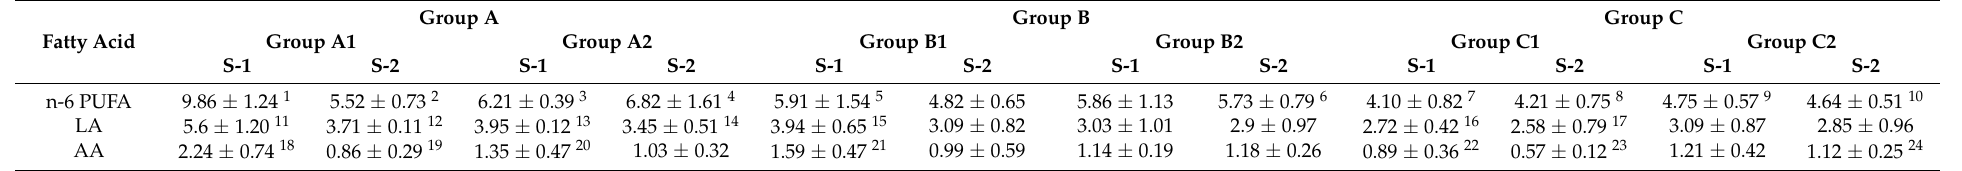
Table 4. Values (mean ± SD) of n-6 PUFA, in muscle of lambs (g/100 g of fatty acids, in dry